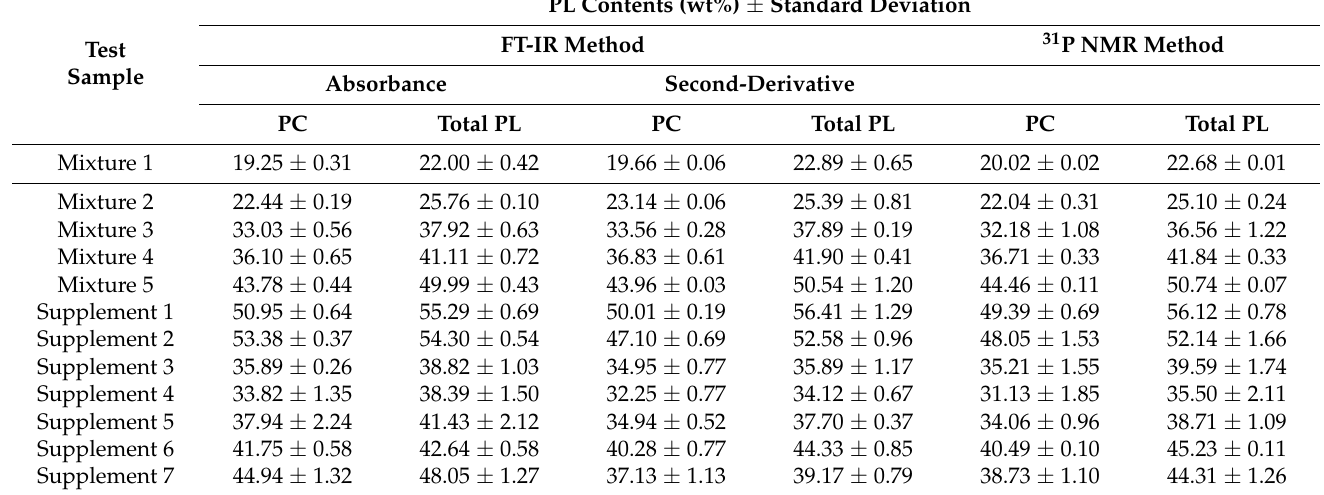
Table 3. PC and total PL contents in krill oil test samples obtained from the FT-IR and 31 P NMR